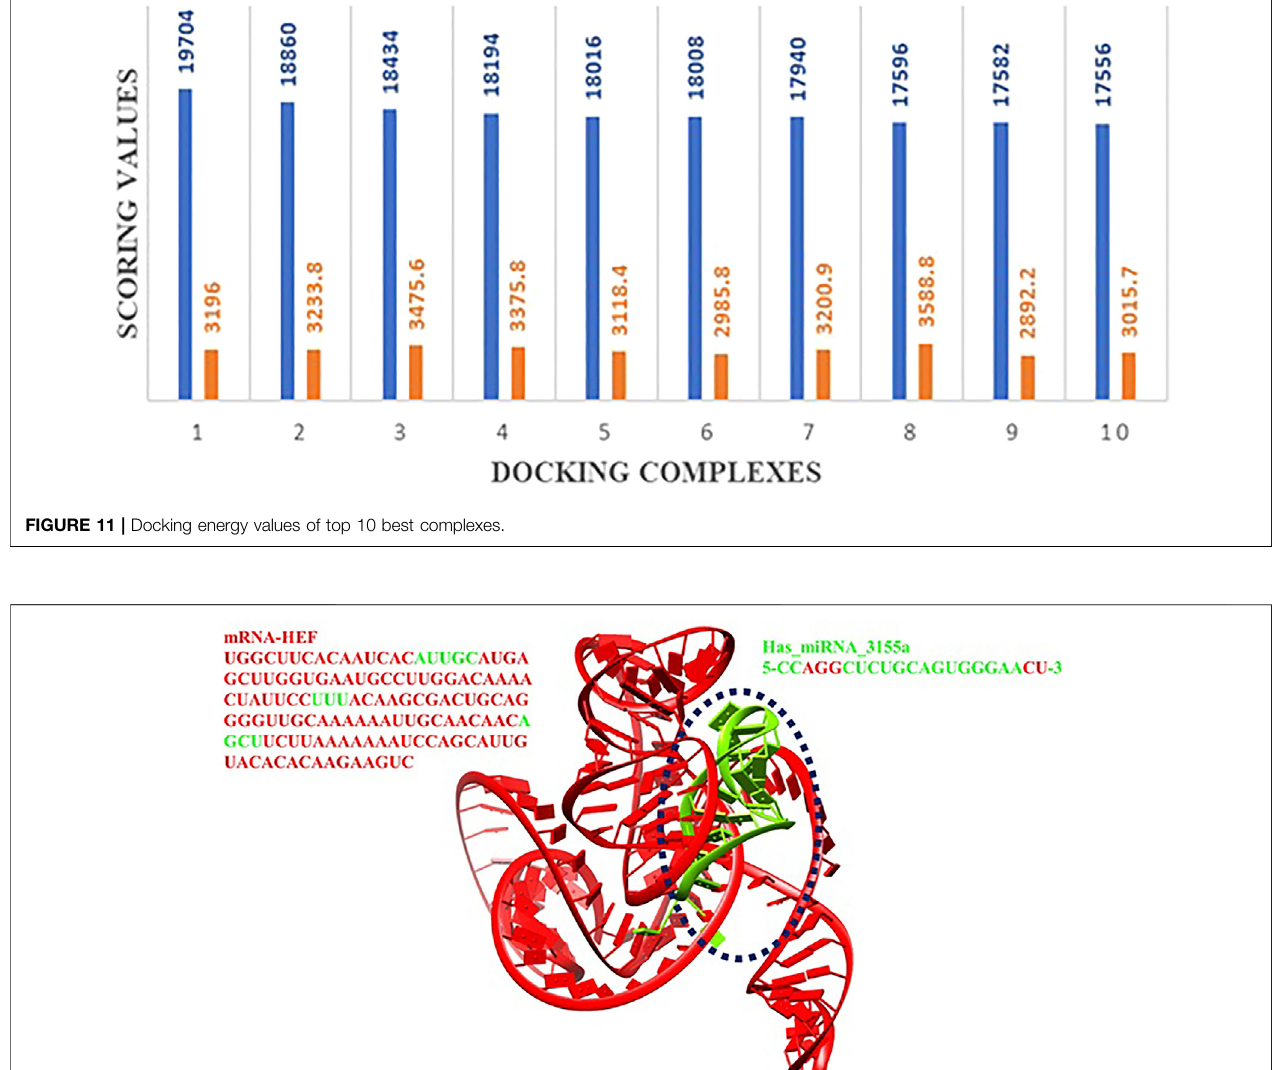
FIGURE 12 | Docking complex of